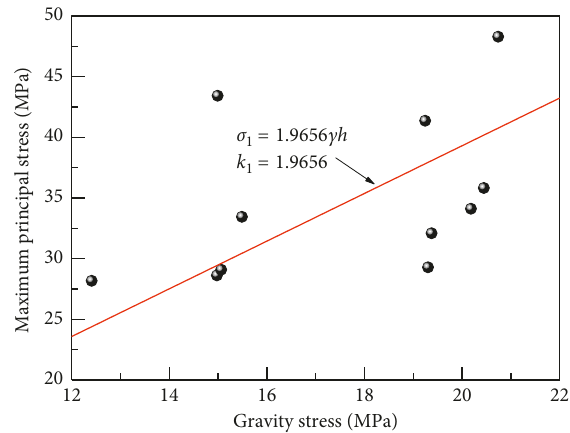
Figure 2: Relationship between maximum horizontal principal stress and gravity stress.